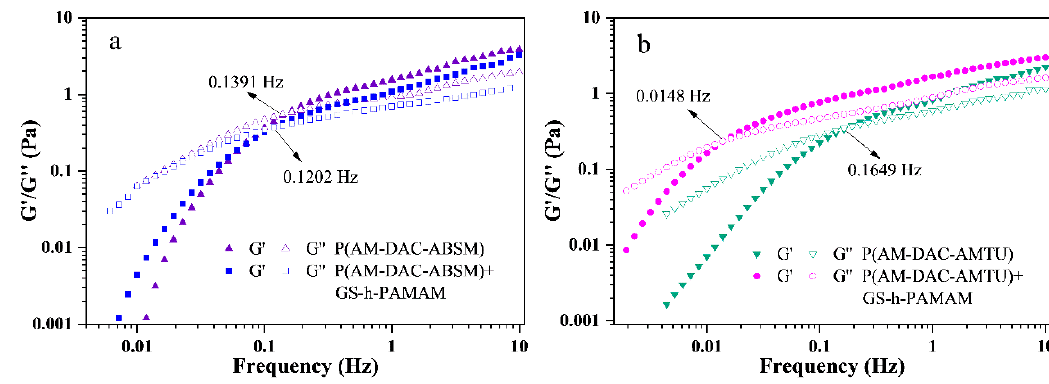
Figure 12. Viscoelasticity behavior of copolymers and compound systems: ( a ) P(AM-DAC-ABSM) and its supramolecular system; ( b ) P(AM-DAC-AMTU) and its supramolecular system.